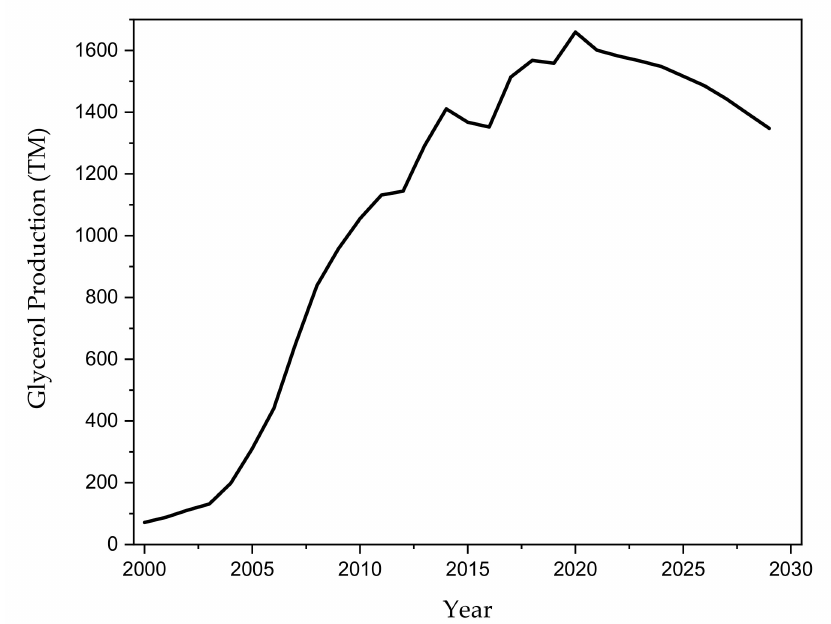
Figure 2. Glycerol production in the biodiesel industry: Trends and future estimations. Adapted from the OECD-FAO 2020 / 2029 database